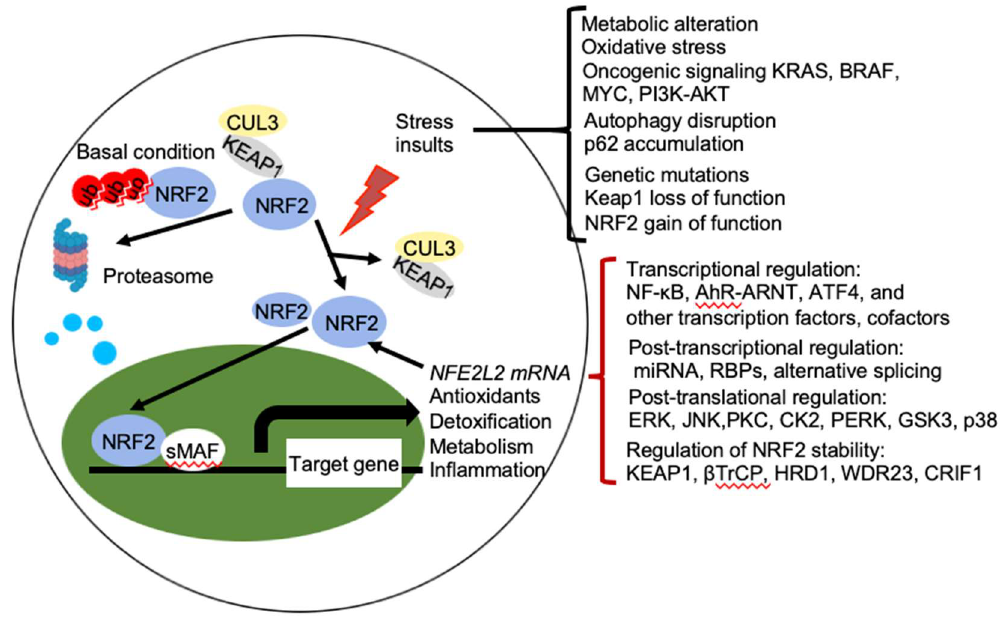
Figure 2. Regulation of NRF2 activity. Under basal conditions, the amount of NRF2 is low due to its continuous sequestration by KEAP1 and subsequent proteasomal degradation. Under stressed